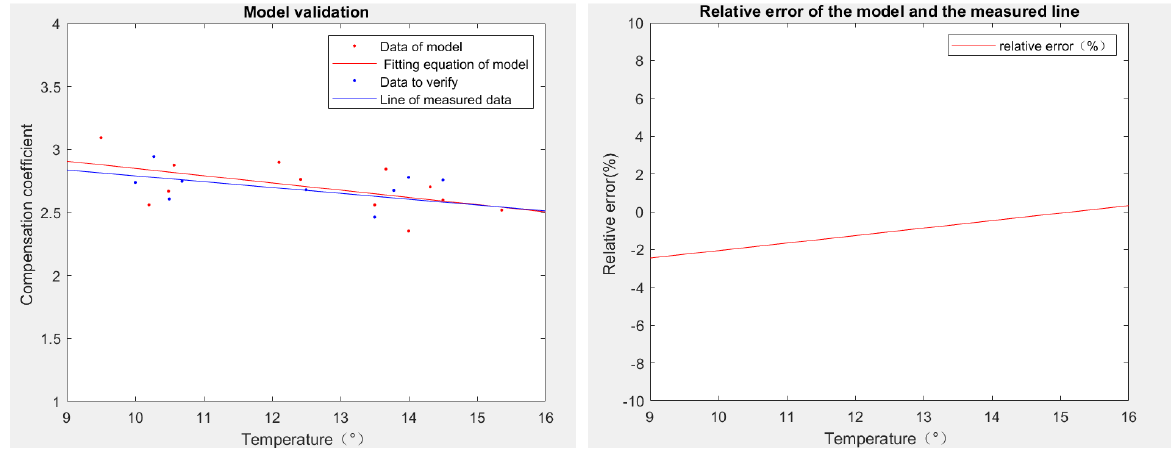
Figure 11. Validation process of compensation coefficient relationship.